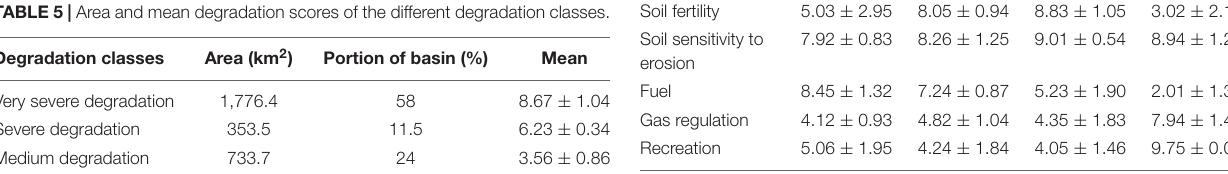
Values represent the mean values (1–10) and standard